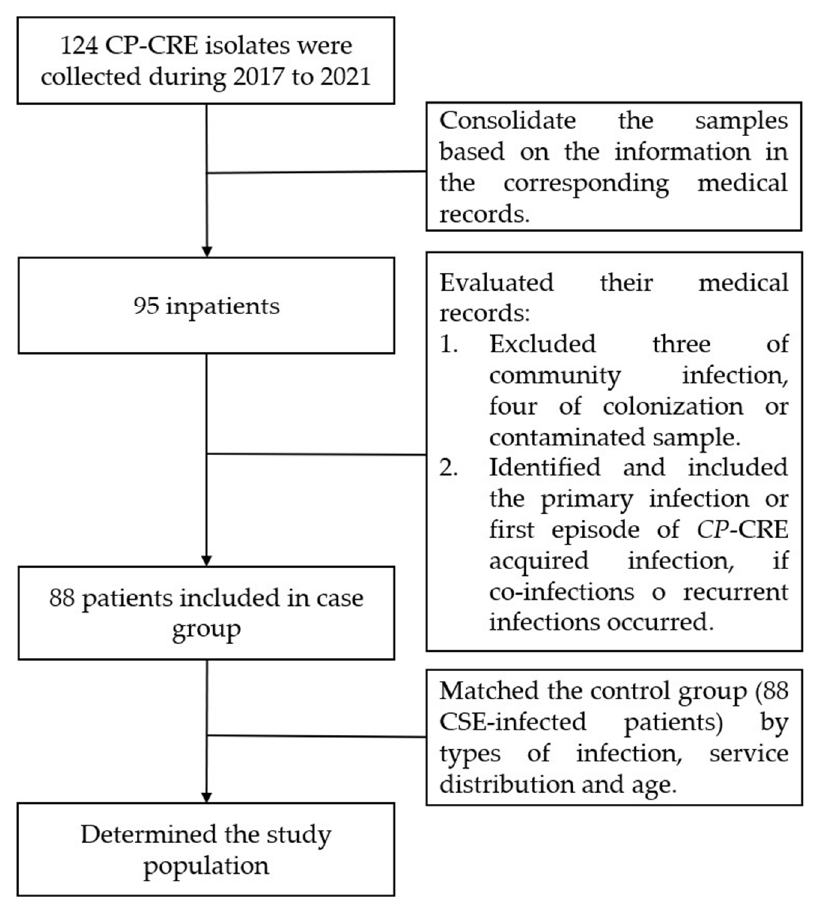
Figure 3. Flow chart of the population identification.